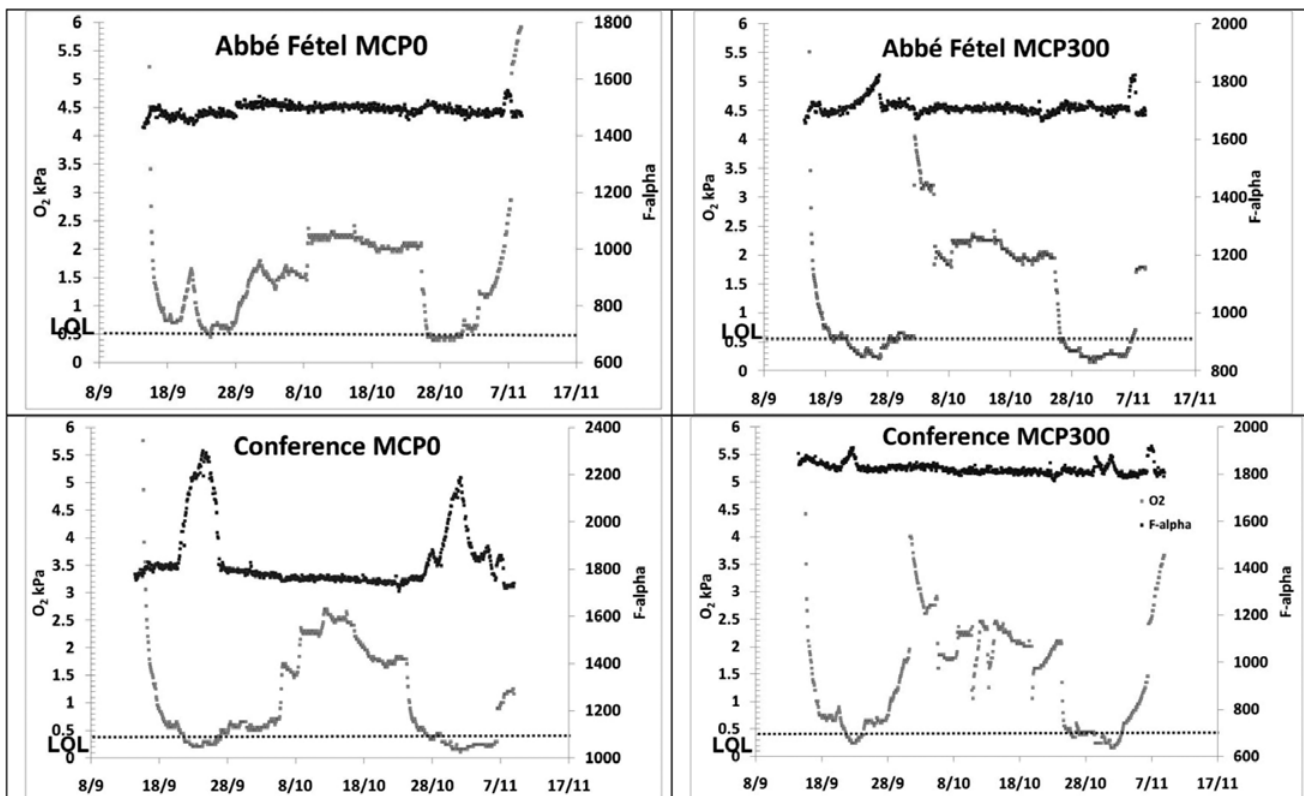
1 - Oxygen partial pressure (gray) and corresponding response of chlorophyll fluorescence F α (black) for control and 1-MCP treated containers of ‘Abbé Fétel’ and ‘Conference’ fruit. The dotted lines indicate the O Fétel’ 0.6 kPa; ‘Conference’ 0.4